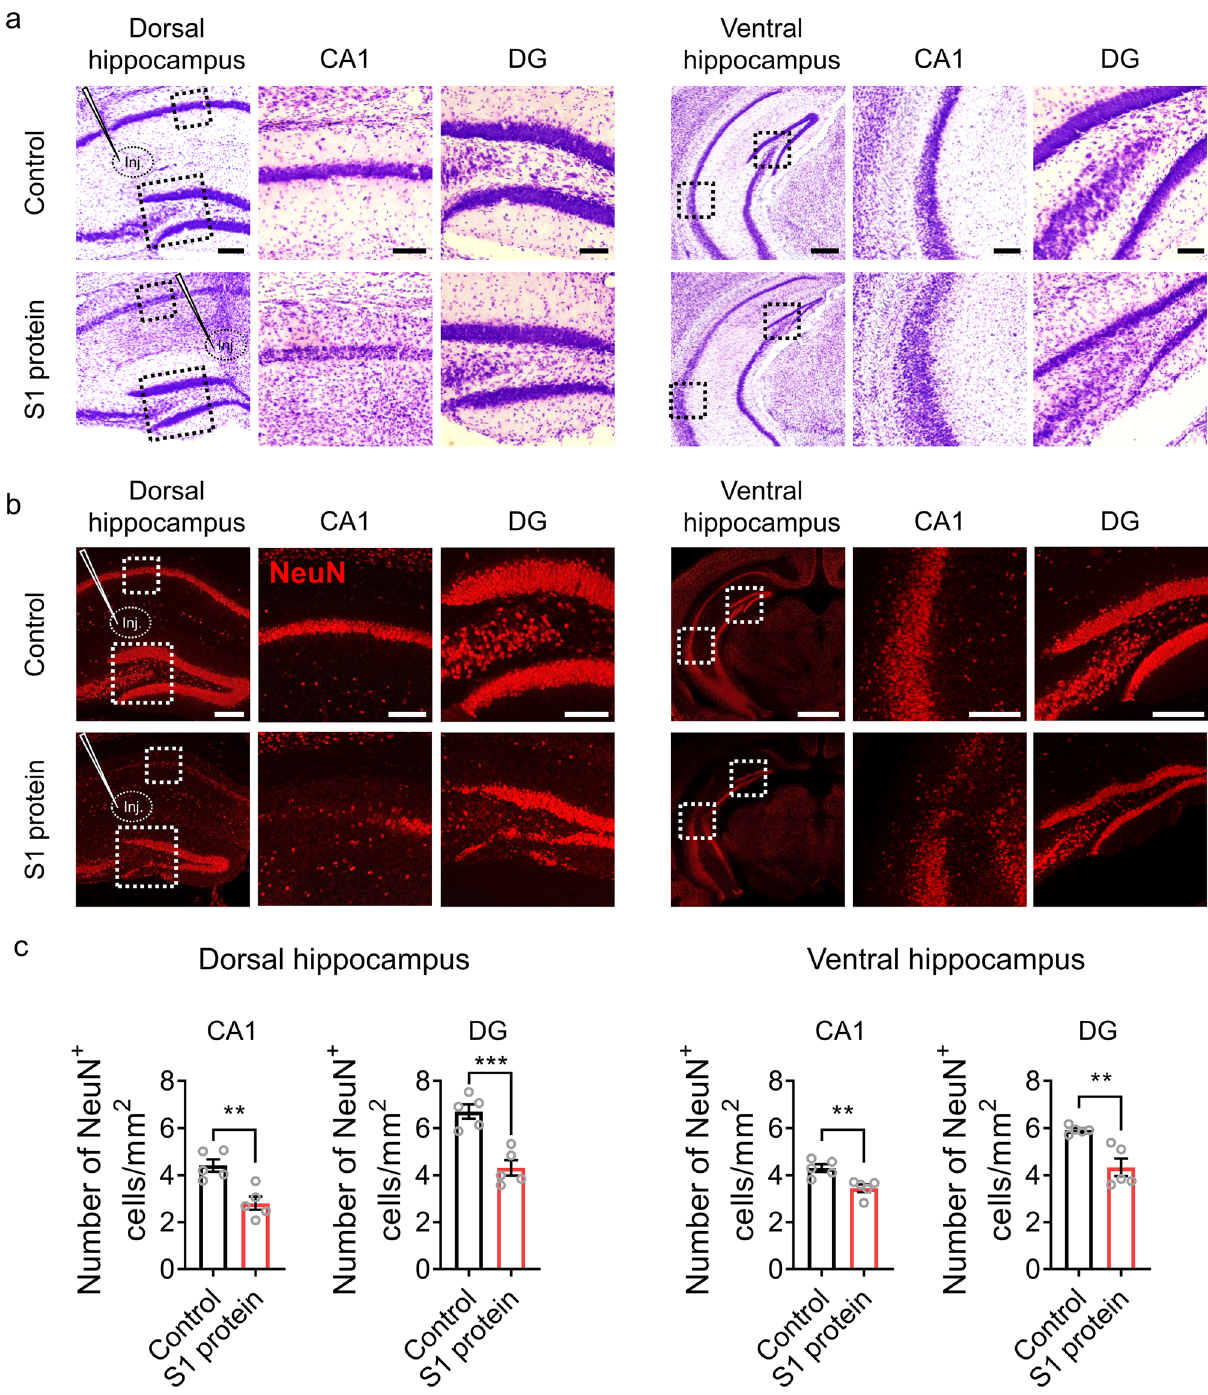
Figure 2. SARS-CoV-2 S1 protein induces hippocampal neuronal death in CA1 and DG areas. ( a-b ). Hippocampal neurons in mice injected with S1 protein (n = 5) or vehicle (Control, n = 5) were visualized by cresyl violet staining (purple, scale bars = 200, 50, and 200 µm for left, middle, and right of dorsal area; 500 µm for left and 125 µm for middle and right of ventral area) and immunostaining with NeuN antibody (red, scale bars = 200, 50, and 100 µm for left, middle, and right of dorsal area; 500 µm for left and 125 µm for middle and right of ventral area). Hippocampal slices were prepared 14 days post-injection. ( c ) NeuN-positive cells in the CA1 and DG regions of the dorsal and ventral hippocampus were manually counted using ImageJ software (Wayne Rasband, National Institutes of Health, USA) in a blind manner. Data are presented as the mean ± s.e.m. Statistical results are for unpaired t -tests. **** p < 0.0001, ** p < 0.01, * p <